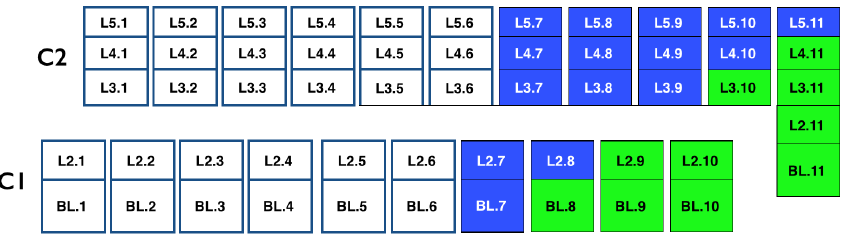
Figure 10. Two streaming classes created from ALD with five-layer and an STF of 6. C1 denotes class one and C2 denotes class